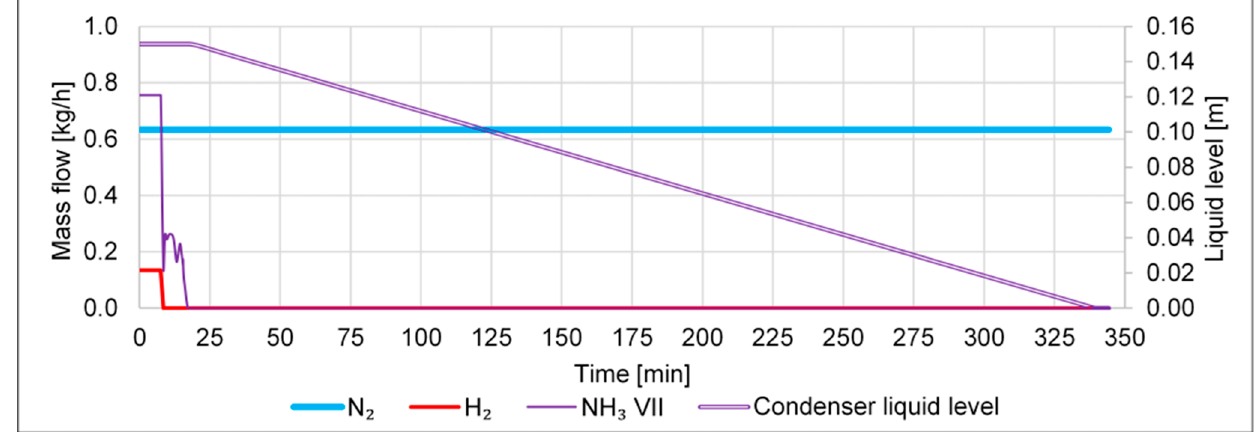
Figure 9 . Selected mass fl ows (left vertical axis) and condenser liquid level (right vertical axis) of Figure 9. Selected mass flows (left vertical axis) and condenser liquid level (right vertical axis) of scenario (d). scenario (d).